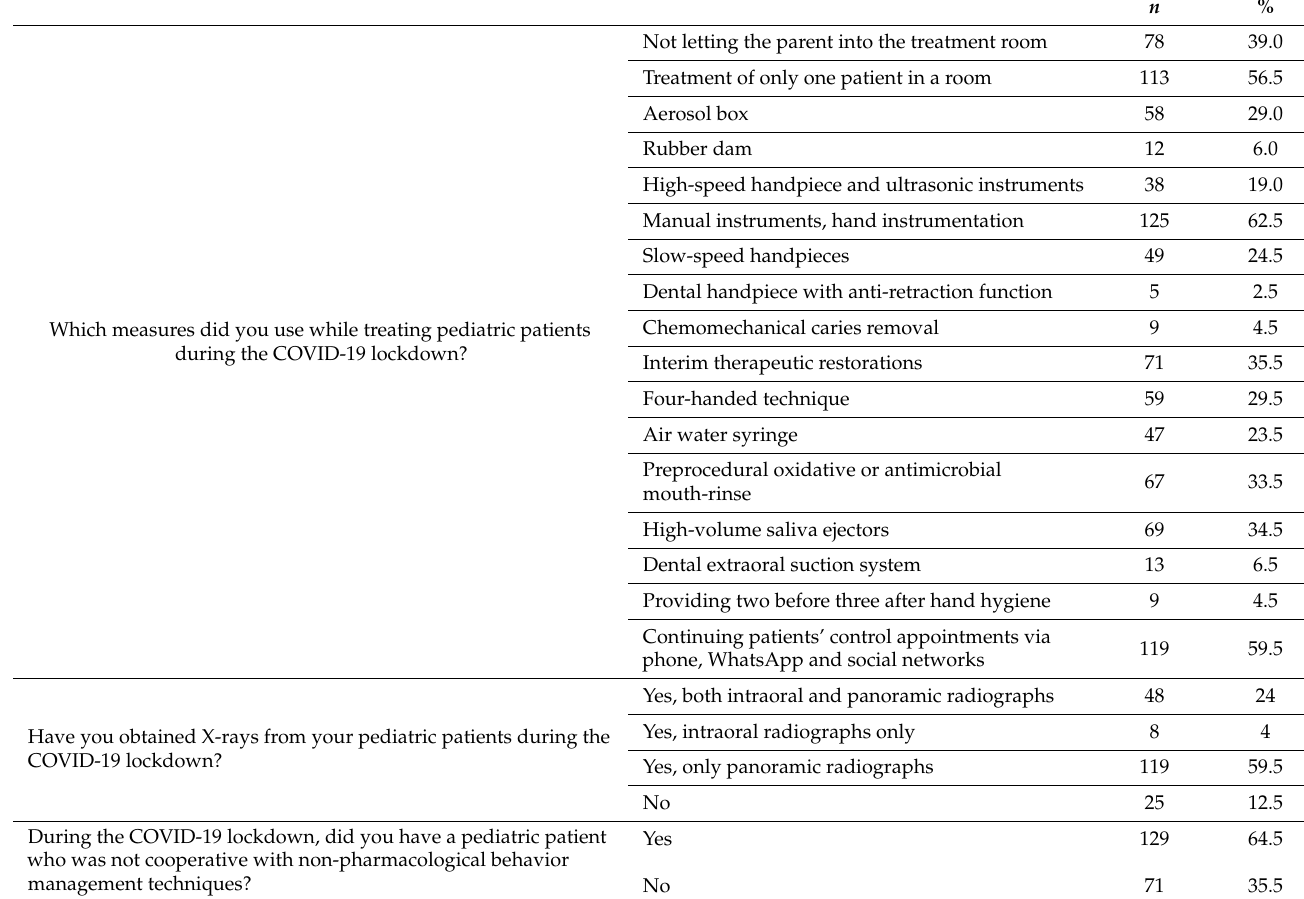
Table 10. Infection control practices used by the participants during treatment.